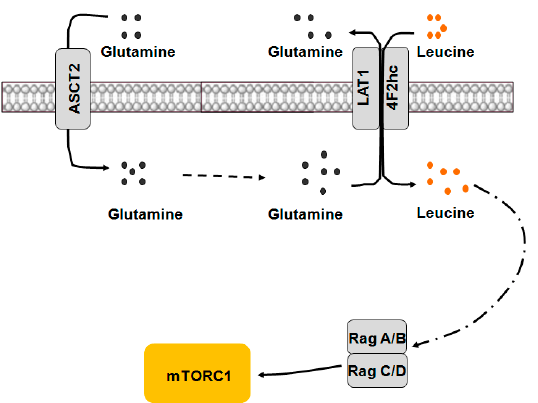
Figure 2. Bidirectional transport of AAs regulates mTORC1 activity. ASCT2 transports glutamine into the cell to increase its intracellular concentration. LAT1-4F2hc is a bidirectional